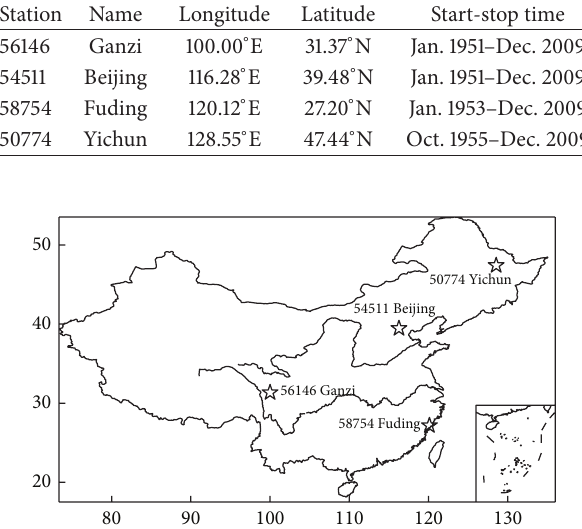
Figure 1: A map of the four selected AGST